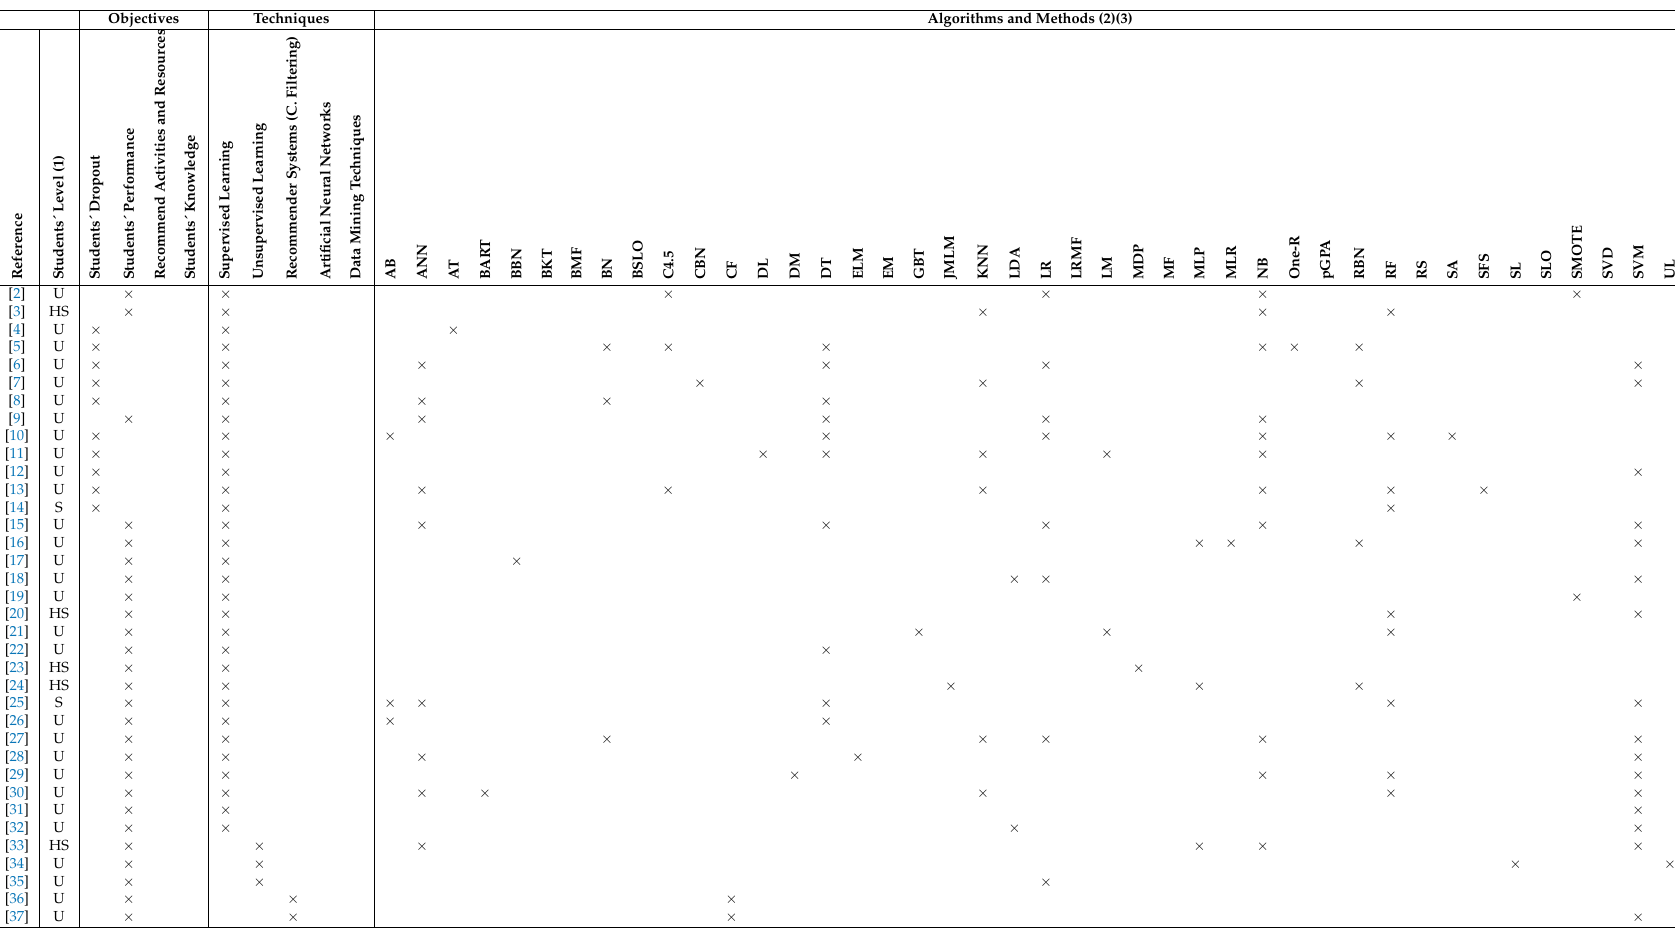
Table 1. Summary of the main features of the literature